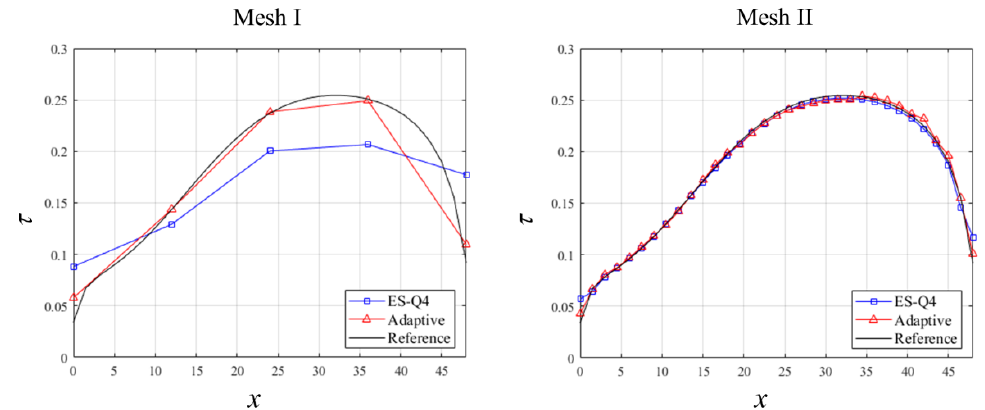
Figure 7. von Mises stress ( τ ) distributions along the line BC of the cook’s skew beam problem for the quadrilateral meshes shown in Figure 5.